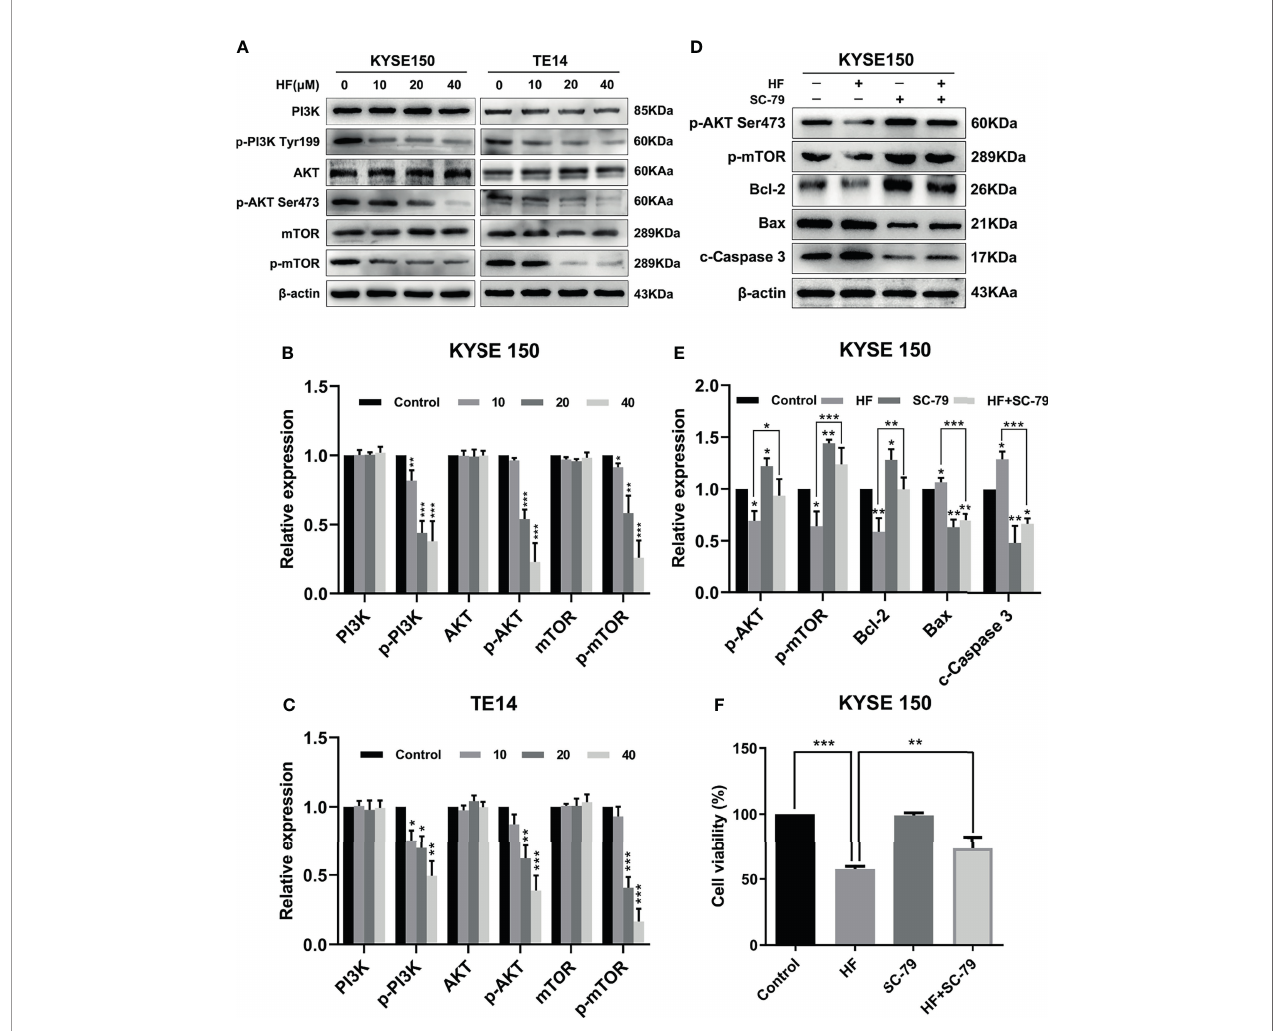
FIGURE 5 | HF induces apoptosis of ESCC cells by negatively regulating the PI3K/Akt/mTOR pathway. (A – C) KYSE150 and TE14 cells received various concentrations of HF intervention for 24 h, and the expression of pathway related proteins PI3K, p-PI3k, Akt, p-Akt, mTOR, and p-mTOR was detected by western blotting and quanti fi ed via densitometric analysis. (D, E) KYSE150 cells were pretreated with SC-79 (10 m M) for 24 h, and the expression of apoptosis related proteins Bcl-2, Bax and c-caspase 3 was determined by western blotting. (F) KYSE150 cells were fi rst cultured with HF with or without addition of SC-79 (10 m M) for 24 h, and cell viability was detected using CCK-8 assays. The above experimental data are presented as the mean ± SD of three independent experiments. * P < 0.05; ** P < 0.01; *** P < 0.001 compared to the control